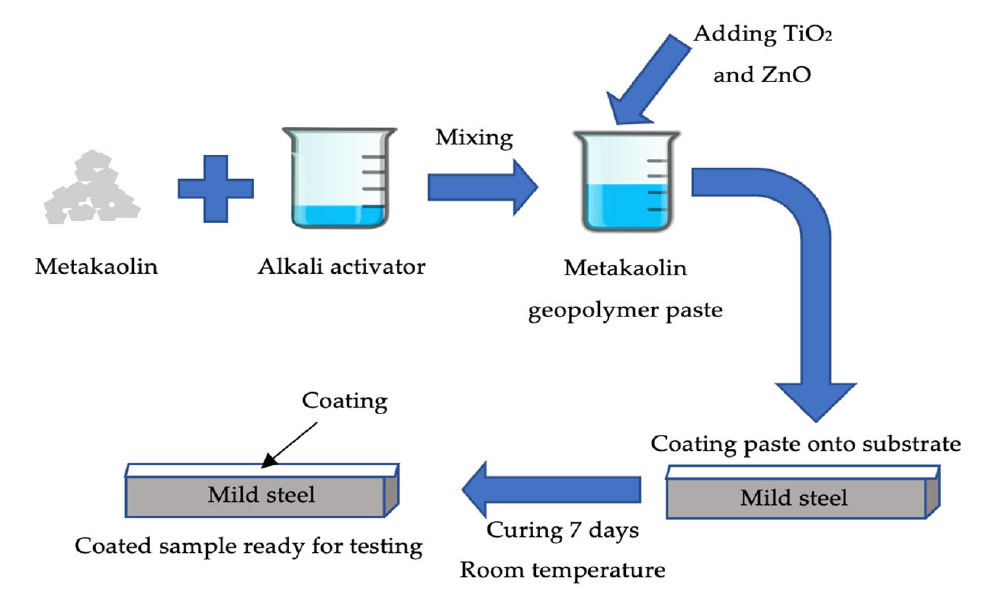
Figure 2. Schematic figure of flow process preparation of metakaolin geopolymer paste for coating.